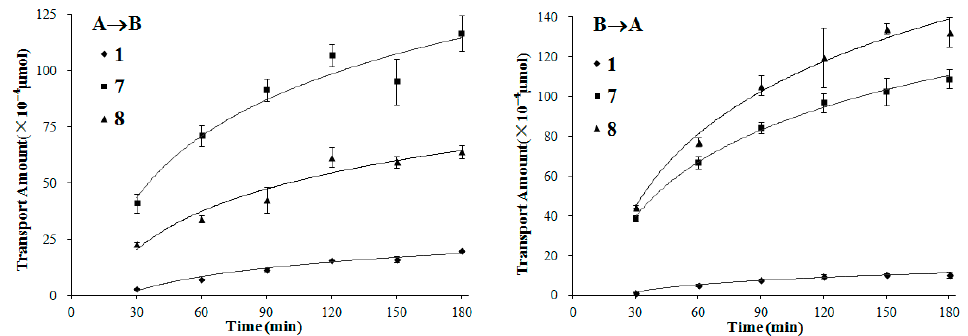
Figure 5. The transport amount at the different time (30–180 min). The experiment was carried out in triplicate. Data are mean ± SD. A → B: Transport from the apical to the basolateral side; B → A: Transport from the basolateral to the apical side.